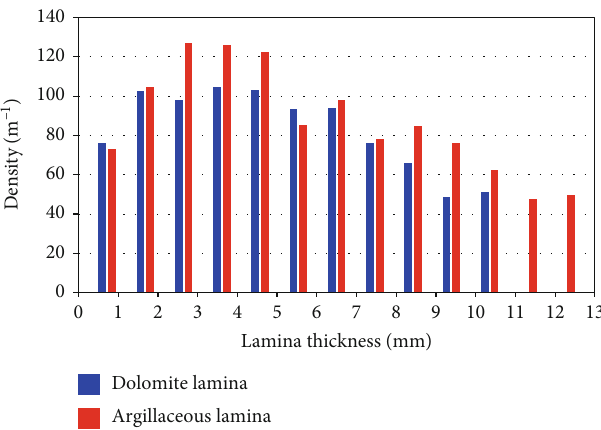
Figure 9: Relationship between density of lamellation fractures and thickness of lamina in the Qianjiang Depression ( N = 283 ).